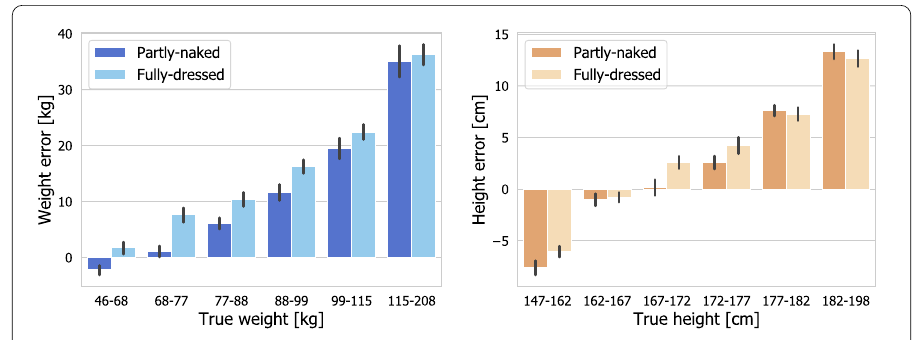
Figure 10 Crowd’s estimation errors by clothing type. Dressed people are estimated as lighter